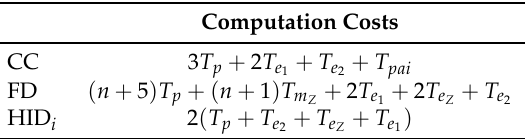
Table 1. The computation cost of